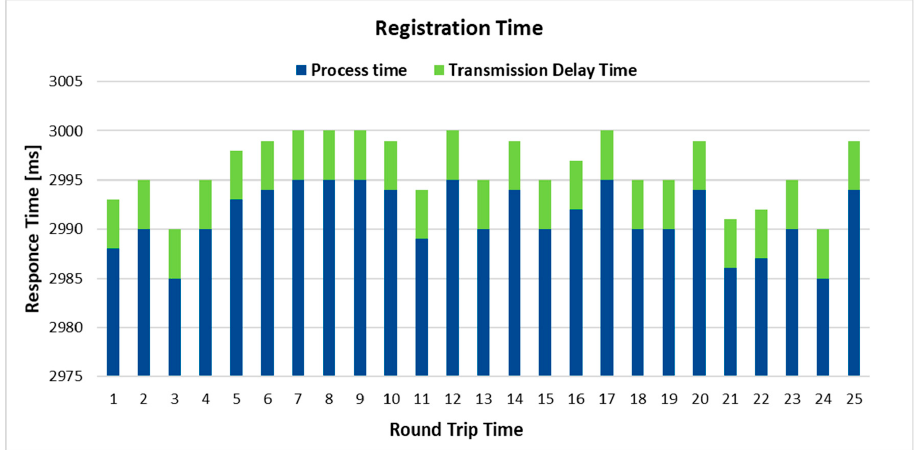
Figure 14. Round Trip Time of the IoT device registration.